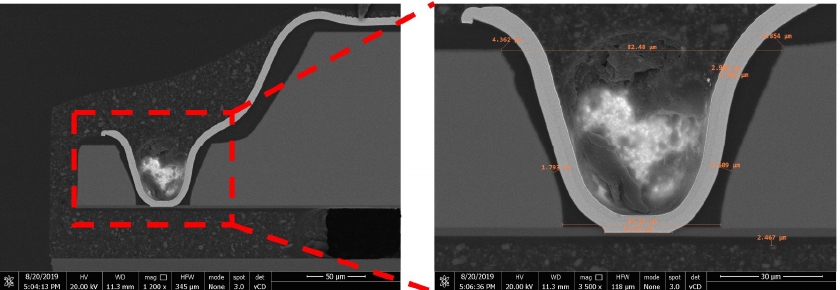
Figure 20. The cross-section SEM image of CIS-WLCSP.